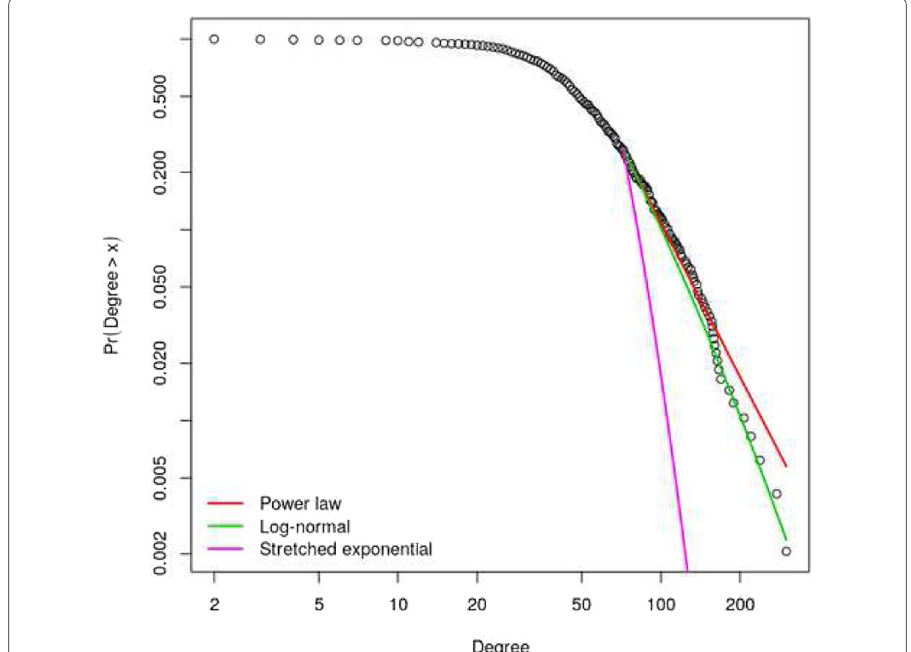
Fig. 4 Degree distribution for threshold 1 (4.7E-3% ). We show the fitted complementary c.d.f.s for a power law, a log-normal and stretched exponential (Weibull) distributions. We estimated x min = 72 using the method of Clauset et al. (2009). For this threshold, the log-normal provides the best fit to data (see text)